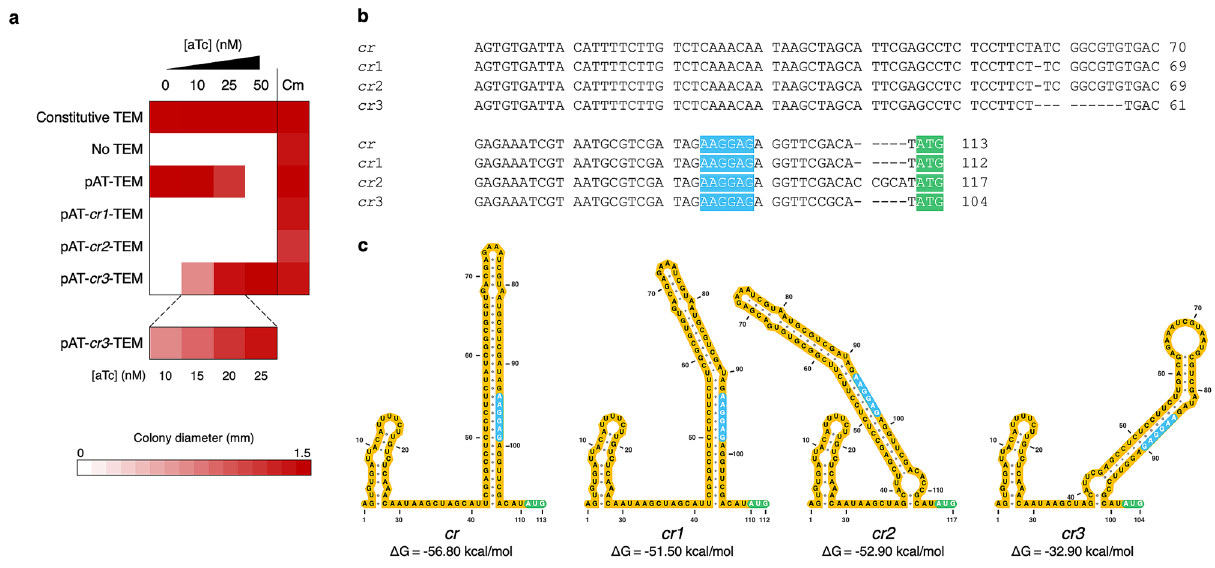
Figure 2. Tuning the dynamic range of the in vivo selection system. ( a ) Heat map representing the average colony diameter of E. coli XL1-Blue expressing the wild-type TEM under the control of different expression vectors. Each TEM-expressing E. coli strain was grown on LB agar plates containing 50 µg/ml ampicillin (LB Amp50) and varying concentrations of aTc as well as on LB agar plates containing 30 µg/ml chloramphenicol (LB Cm30) at 37 °C for 24 h. E. coli XL1-Blue pAT containing no TEM gene and E. coli XL1-Blue pAT-TEM c , which constitutively expresses TEM, were used as the negative and positive controls, respectively. Colony diameters were determined by ImageJ 25 . The raw data are shown in Table S1. ( b ) The sequence alignment of the original cis repressor and its mutants. ( c ) Cis repressor secondary structures predicted by Mfold 26 . Ribosome binding sites and start codons are highlighted in blue and green, respectively. The graphical representation of cis repressor structures was generated by VARNA 27